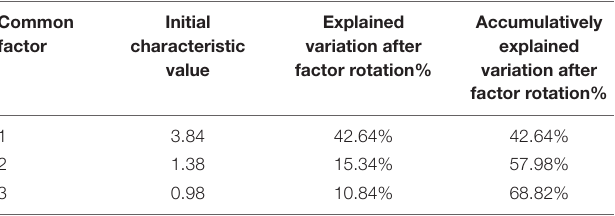
TABLE 3 | Characteristic values of the extracted common factors for patient